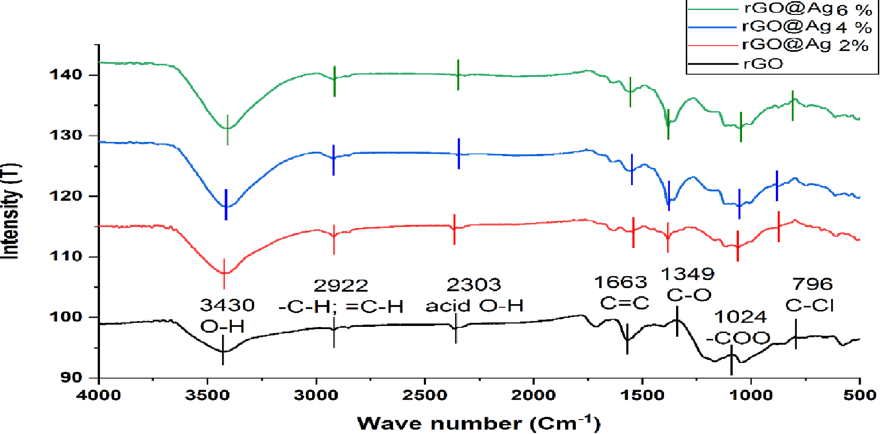
Fig. 7 FT-IR of rGO, rGO@Ag 2%, rGO@Ag 4% and